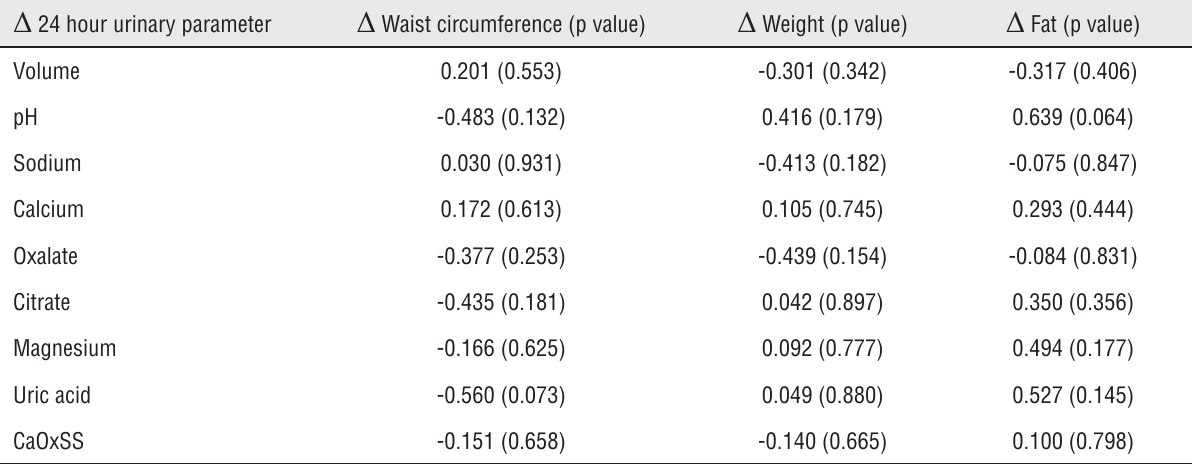
Supplementary Table 6 - Correlation between 24-hour urinary parameters change and weight change, abdominal circumference change and fat mass change in 12